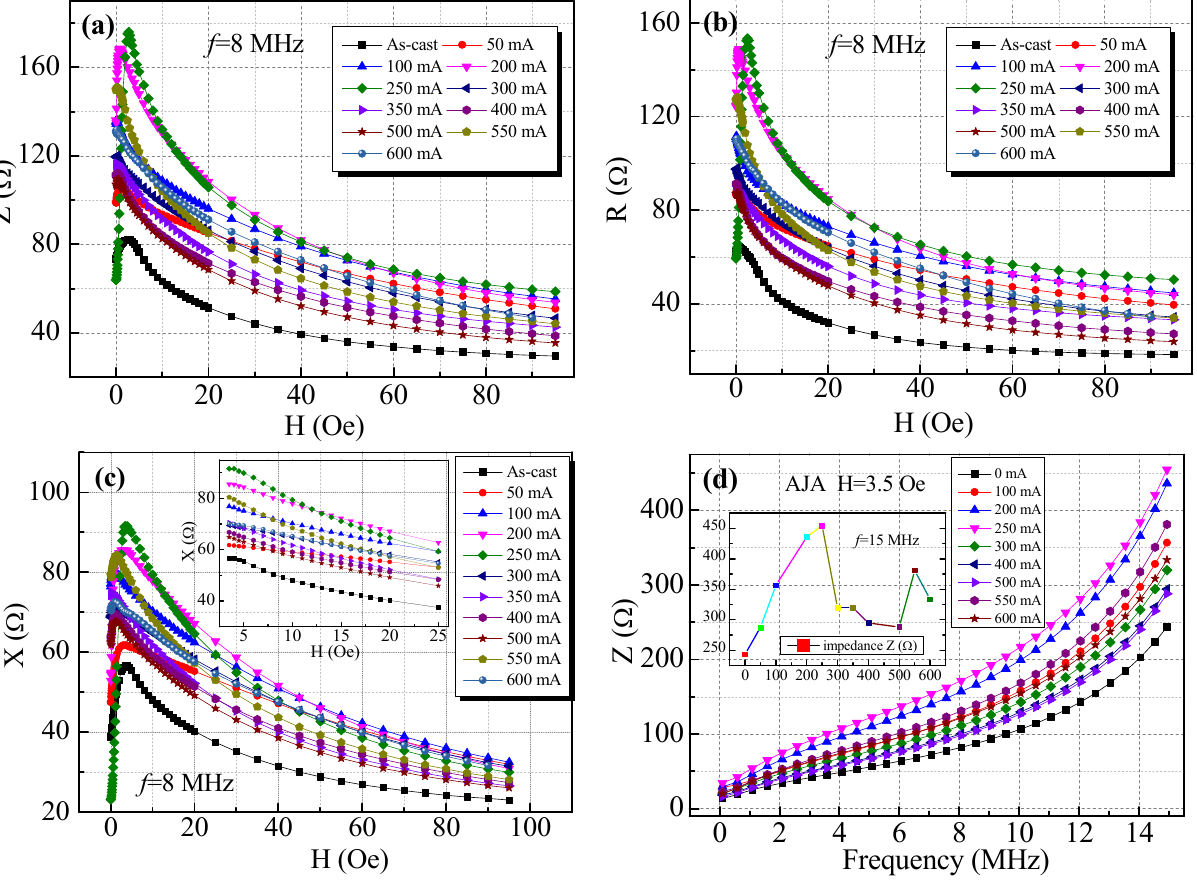
Figure 4. Field dependence of the impedance Z ( a ), resistance R ( b ) and inductive reactance X ( c ) for the 0~600 mA AJA microwires at f = 8 MHz. ( d ) Frequency dependence of the impedance Z with the 0~600 mA AJA ‐ ed current amplitudes at H ex = 3.5 Oe.